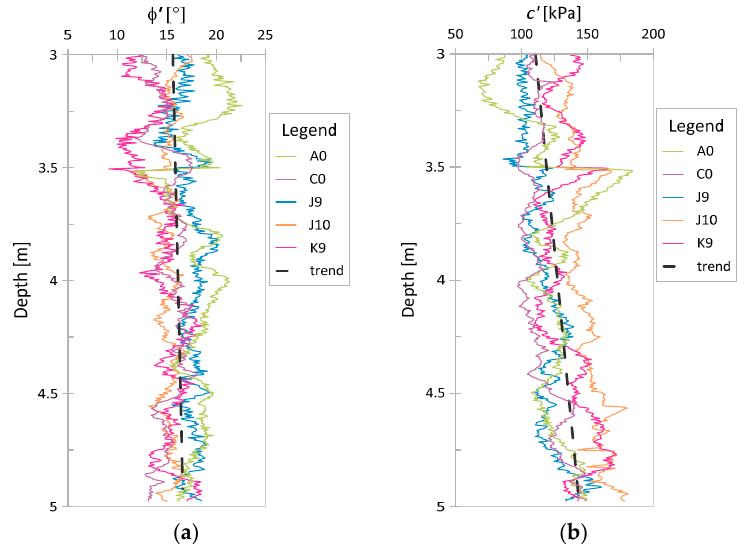
Figure 13. MoE results for Keswick clay: ( a ) ϕ ′ ; ( b ) c ′ . Table 7. Variability measures of parameters according to the MoE.